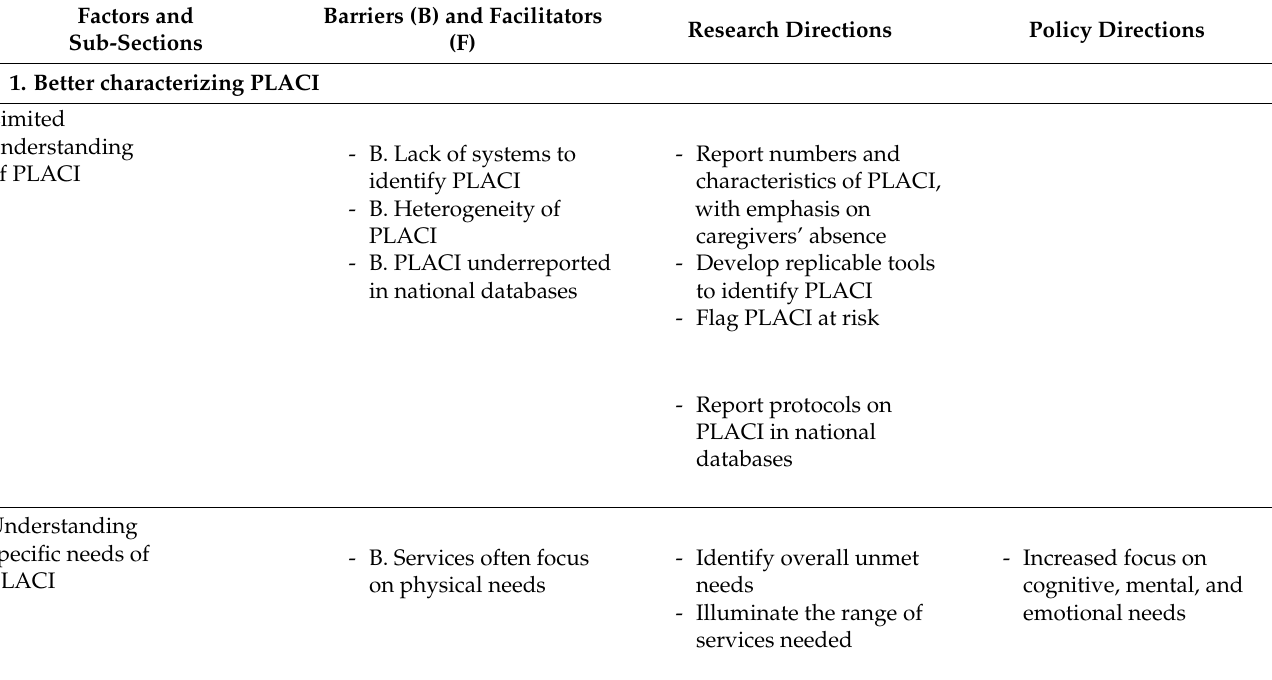
Table 2. Overview of